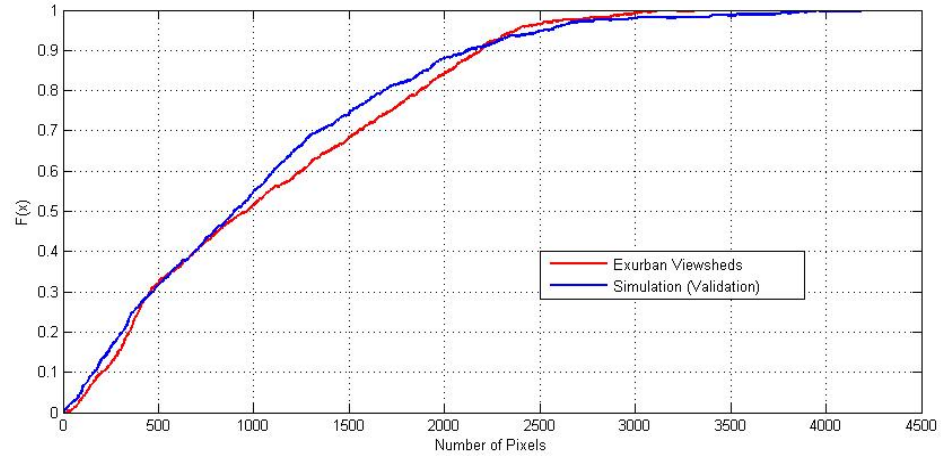
Figure 5. Cumulative distribution functions of viewshed size for actual exurban and simulated (validation)